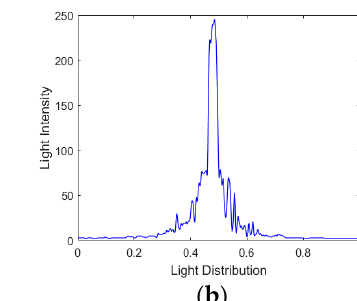
Figure 5. ( a ) The focal spot image captured by Charge-coupled Device (CCD) without aberration disturbance; ( b ) light intensity distribution